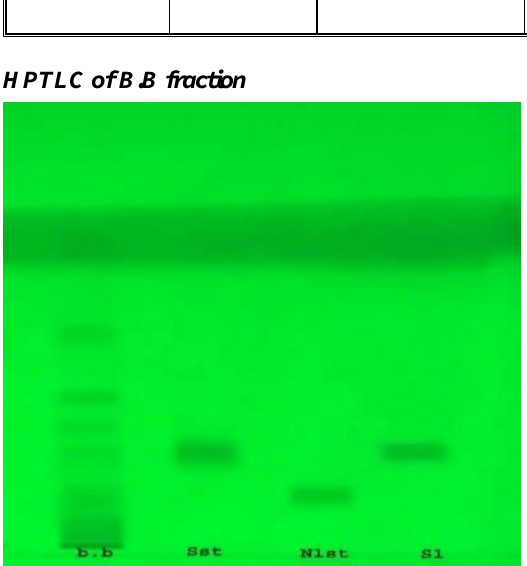
Figure 2 .HPTLC of analyzed fraction and reference standard at 256nm (Pst=protopine standard Sst=salicin standard, Nst=neohesperidin standard, P1=C1=isolated compound from chA fraction, aq.f=aqueous fraction after butanol hydrolysis, S1=isolated compound from B.B, chA=acid-base purification of chloroform fraction. Developed in